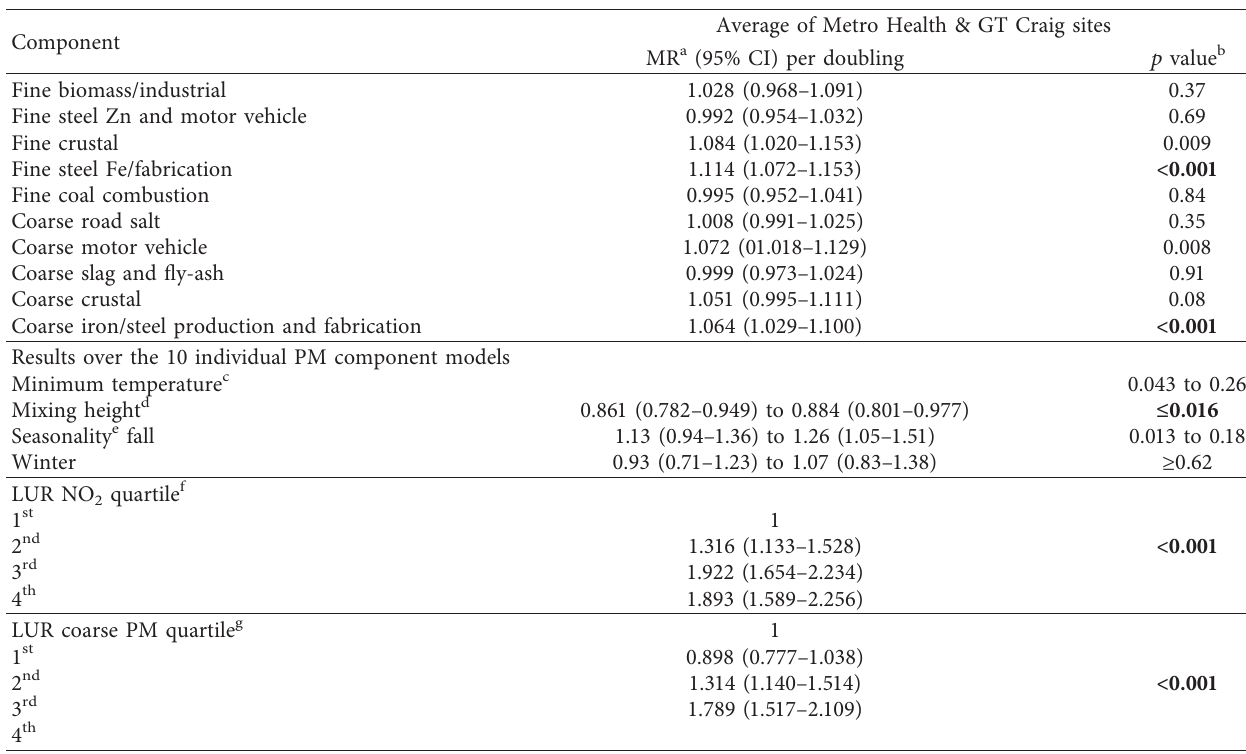
Table 3: Poisson regression models for each of the fine and coarse PM components individually, adjusting for daily minimum temperature, daily median mixing height, and NO 2 LUR